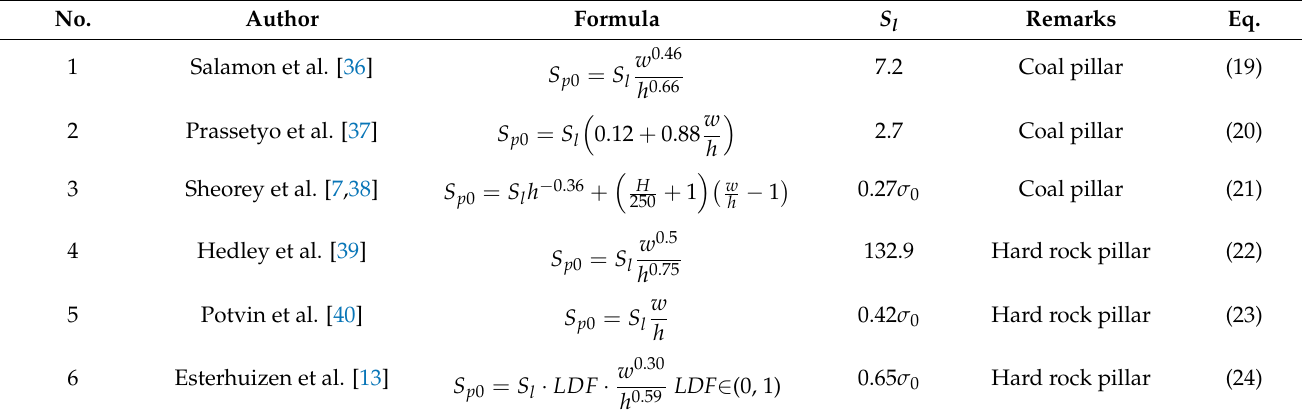
Table 3. Strength formulas of partial vertical pillars (coal pillars and hard rock pillars).